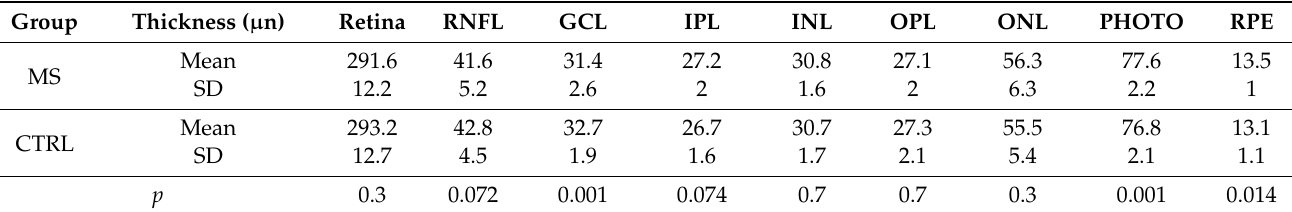
Table 2. Posterior pole retinal layers thickness values and statistical differences between patients with MS and the control